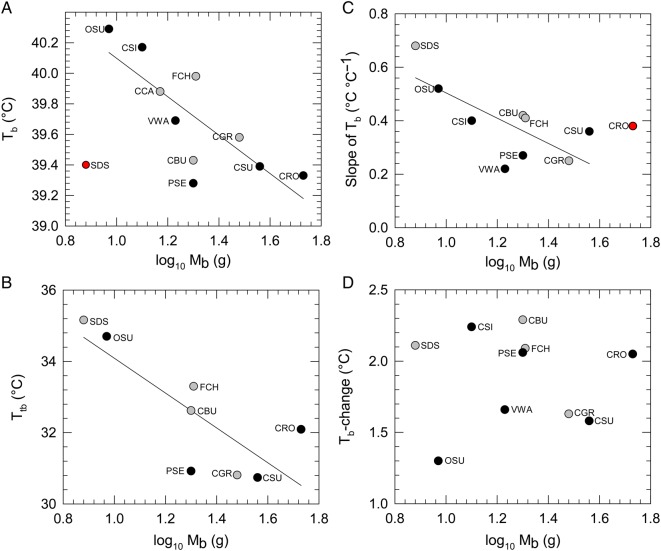
Body temperature (Tb, approximating levels within the thermoneutral zone; A), inflection air temperature for Tb (Ttb; B), rates of increase in Tb above inflection air temperature for Tb (slope of Tb; C) and Tb-change (Tb at Tair = 38°C minus Tb at Tair = 30°C; D) as a function of log10 body mass (log10Mb). Black circles represent Fynbos endemics and grey circles represent non-endemics. Trend lines represent significant relationships (P < 0.05), excluding outliers (red circles). Each species' data point is labelled with a three-letter acronym, as in Fig. 1.